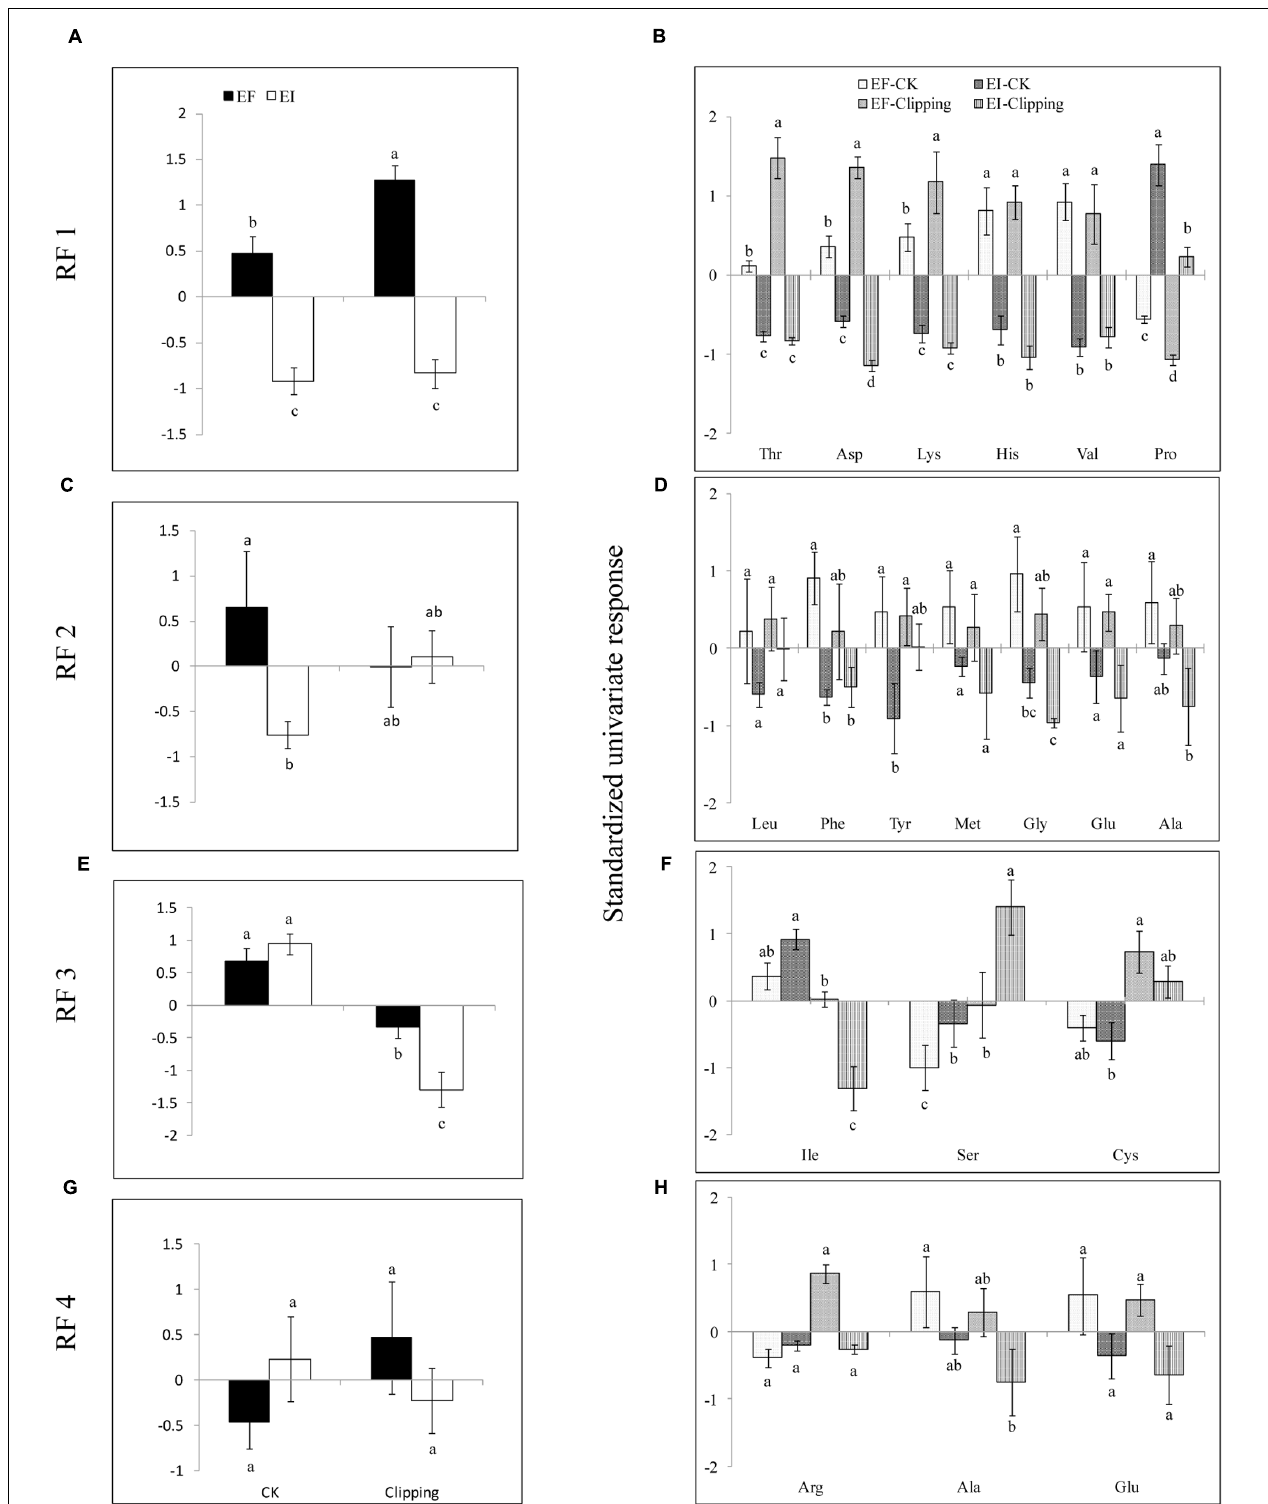
FIGURE 3 | Mean response of rotated factors (RF 1–4, A,C,E,G) and the standardized univariate response (B,D,F,H) of individual amino acids in EI and EF A. sibiricum under unclipping (CK) and clipping treatments. Different lower-case letters denote means that are significantly different ( P < 0.05).